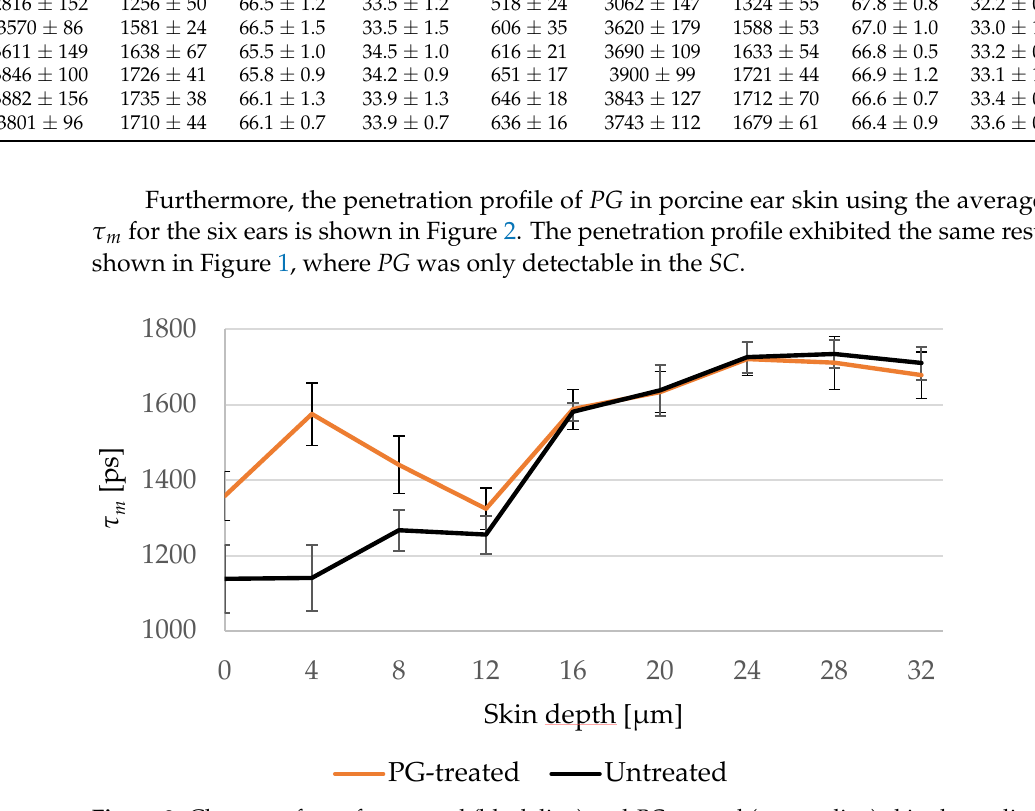
Figure 2. Changes of τ m of untreated (black line) and PG -treated (orange line) skin depending on the depth at 4 µ m increment. PG -treated skin shows longer τ m down to 8 µ m. SC thickness is 16.0 ± 3.3 µ m. N = 6.